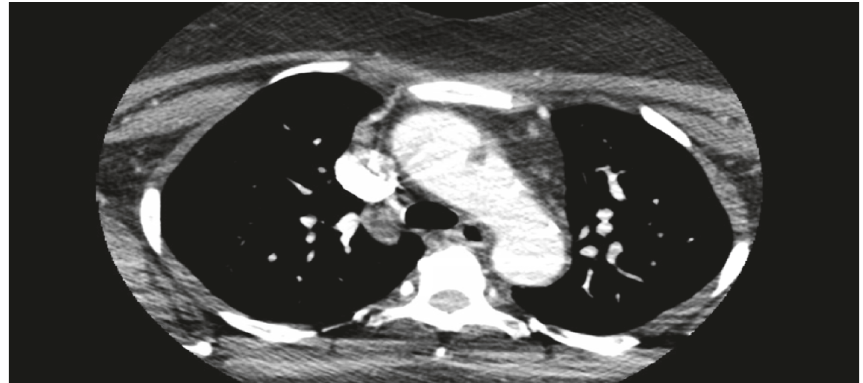
Figure 3: CT Angiogram of head and neck showing a 1.3 cm filling defect in the proximal aortic arch abutting the lateral wall of the aortic arch, consistent with thrombus. Abbreviation. CT: computed